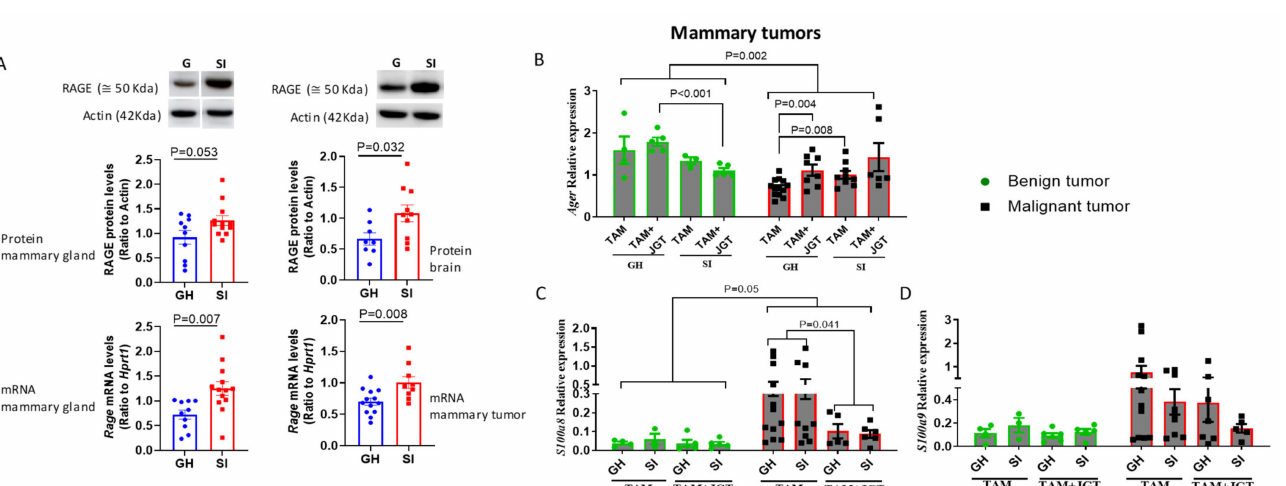
Figure 8. Alterations in the Il6 mRNA and pSTAT3 protein levels in mammary tumors. ( A ) Il6 mRNA levels and ( B ) pSTAT3 protein levels in mammary tumors during tamoxifen therapy in GH and SI rats. SI significantly increased the expression of Il6 in benign tumors, and the difference was eliminated by Jaeumganghwa-tang (JGT). JGT significantly reduced Il6 in both the GH and SI rats in malignant tumors. In benign tumors, SI significantly increased the protein levels of pSTAT3, and JGT significantly reduced the levels in SI rats. Statistical analysis was conducted using 2-way ANOVA followed by the Holm–Sidak test. Means ± SEM, n = 3–13 per group are shown.